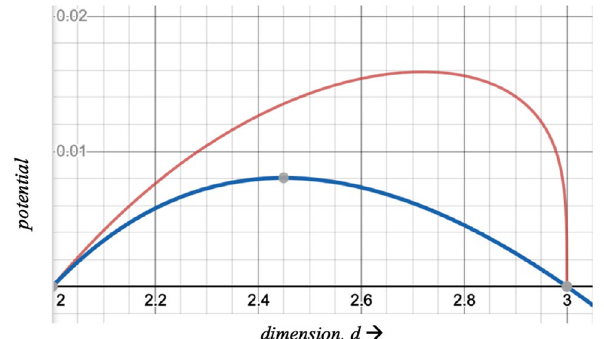
Figure 3. Potential with respect to dimensionality; blue line p 3, B ( d ) , and red line p 3, C ( d )